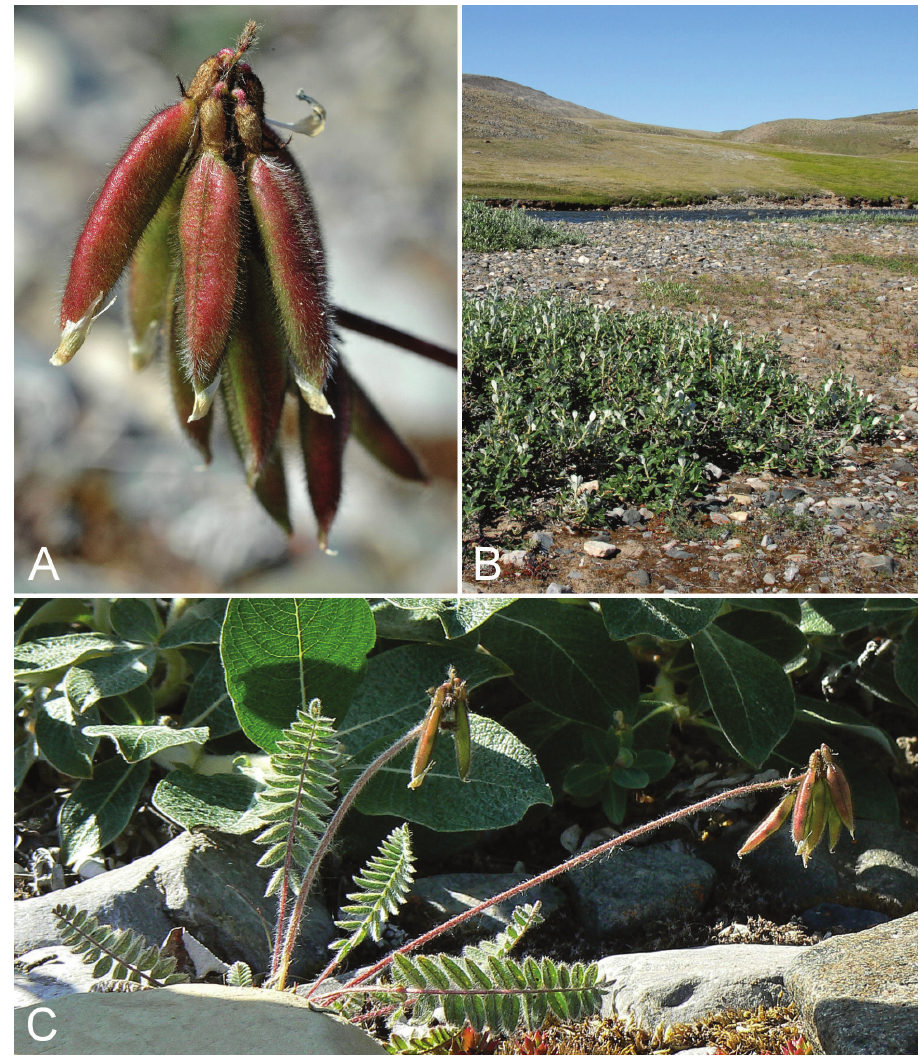
Figure 14. Oxytropis deflexa subsp. foliolosa : A fruits B habitat C habit, Gillespie et al. 10129 . Photo- graphs by R.D. Bull ( A ), L.J. Gillespie ( B ), P.C. Sokoloff ( C